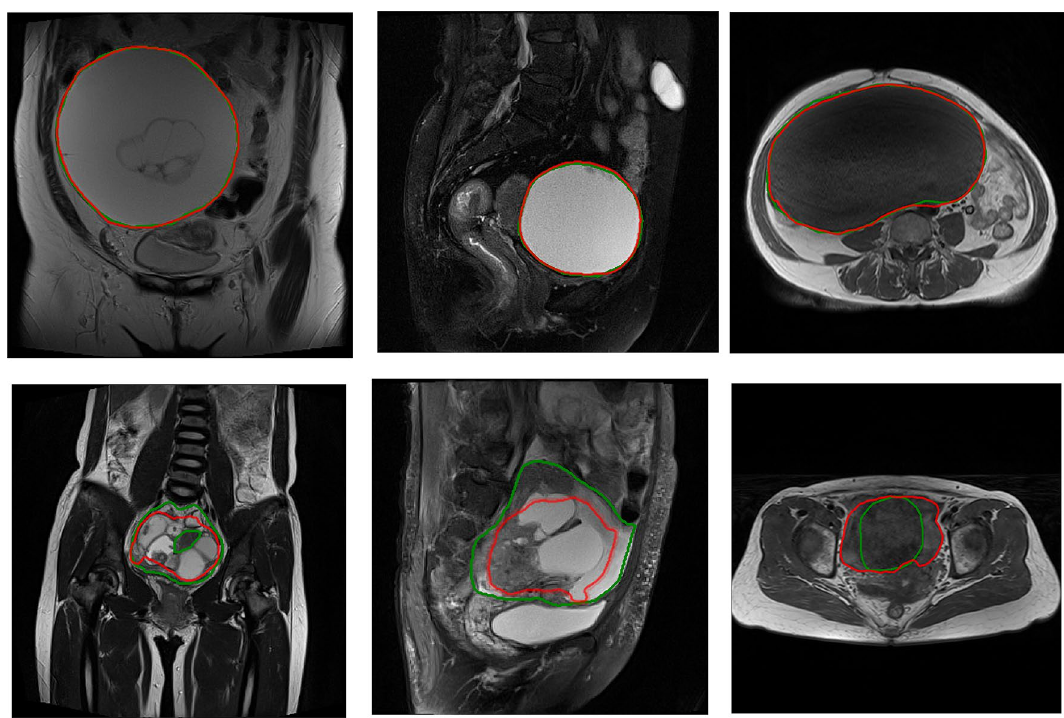
Figure 5. The segmentation results on MR images. The segmented ovarian tumor regions by U-net++ network (the red line) and operator (the green line, ground truth) are shown on coronal T2WI (left column), T2WI sagittal (middle column), and T1WI (right column). The top row represents precise segmentation cases with Dice values over 0.9 and the bottom row represents poor segmentation cases with Dice values less than